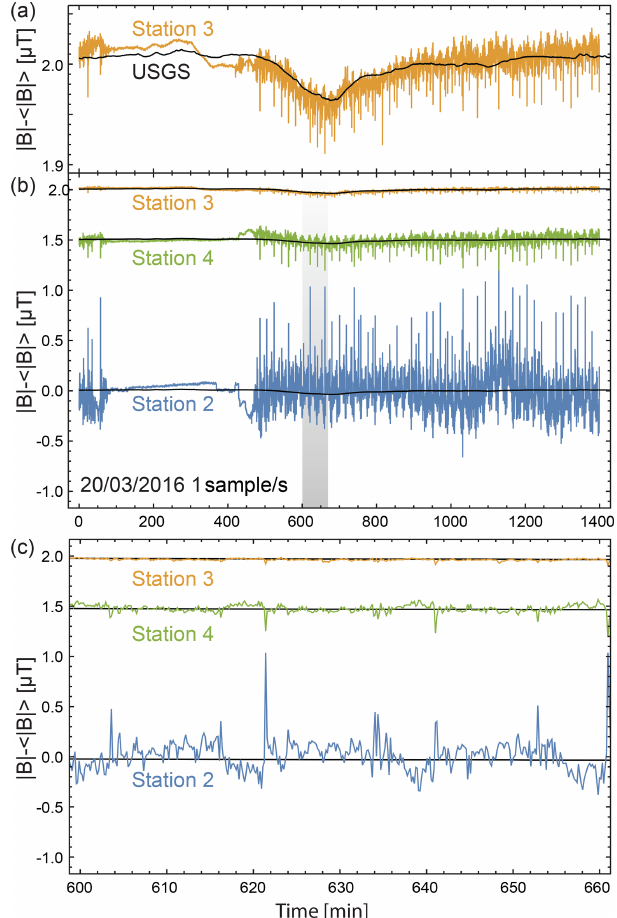
Figure 4. Magnetic field magnitudes for three stations at a cadence of one sample per second on 20 March 2016. Panel (a) shows close agreement between the geomagnetic field measured by a USGS sta- tion in Fresno, CA, and sensor 3. Panel (b) shows 24h scalar magni- tudes (DC values were adjusted for plotting purposes) for the three active sensors; the magnitude of fluctuations decreases with increas- ing distance from the BART train line. The grey bar represents 1h of data from 10:00 to 11:00PDT; a better visualization of that region can be seen in panel (c) . The 1min averaged USGS geomagnetic field data are shown in each plot as a black